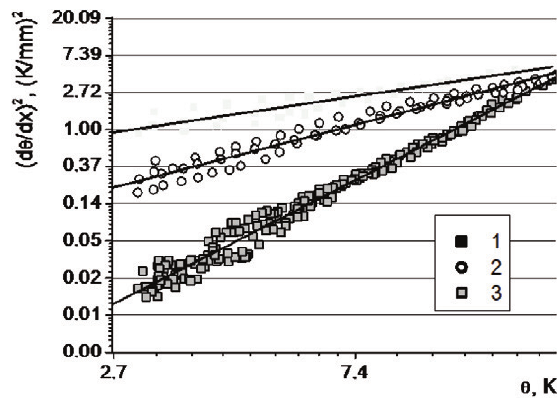
2.7 Figure 8. Boiling curves for distilled water (3K < q < 13K); 1 – metal-fibrous microstructure of 81% porosity, 2 – metal- fibrous microstructure of 67% porosity, 3 – smooth surface